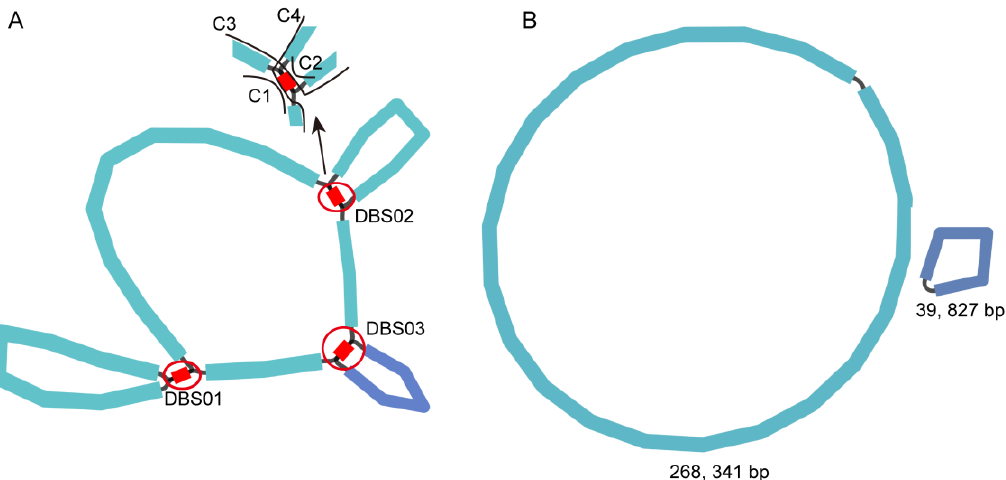
Figure 2. Schematic representation of the assembly steps of S. officinalis mitogenome. ( A ) Unitig graph of the S. officinalis mitogenome obtained from de novo assembly of Illumina reads with GetOrganelle. The unitig graph contained six contigs (blue and purple) that formed DBSs (DBS01–03, highlighted in the red circles). Each DBS has four conformations (c1, c2, c3, and c4), as shown in the top left corner, with DBS02 as an example. ( B ) The mitogenomic chromosomes MC1 (light blue circle) and MC2 (dark blue circle) of S. officinalis after the DBSs shown in ( A ) were resolved using Unicycler software.